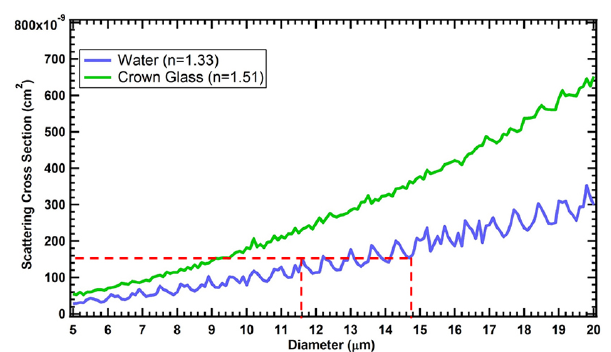
Figure 5. The theoretical response of the backscatter cloud probe is shown in this diagram that relates the scattering cross section of particles to their diameter, calculated from Mie theory assuming spherical particles, a wavelength of 685nm and the refractive in- dices for water (1.33) and crown glass calibration beads (1.51). The red dashed line indicates an example where two particles with dif- ferent diameters have the same scattering cross section and cannot be uniquely identified by their light scattering intensity.